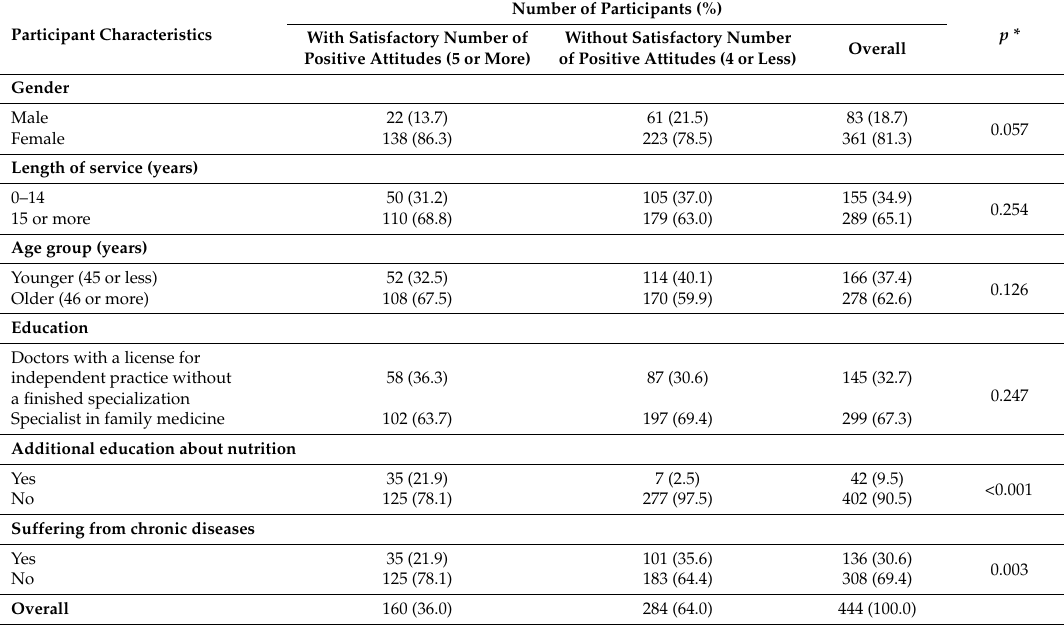
Table 1. The Croatian GPs with and without a satisfactory number of positive attitudes toward the significance of nutrition in the treatment and prevention of chronic diseases and toward nutrition care according to their sociodemographic